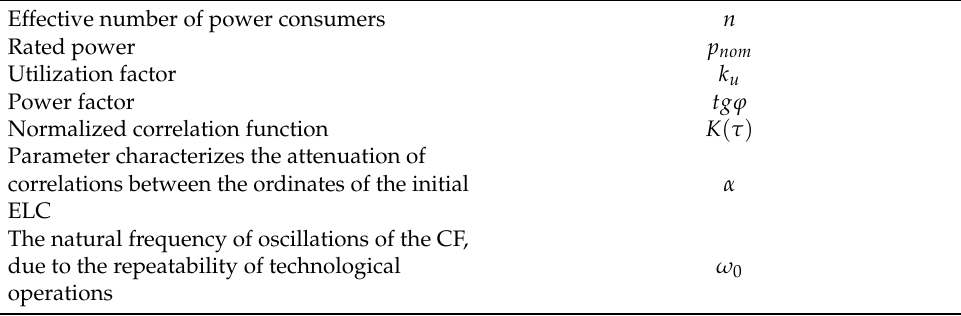
Table 5. Database with additional